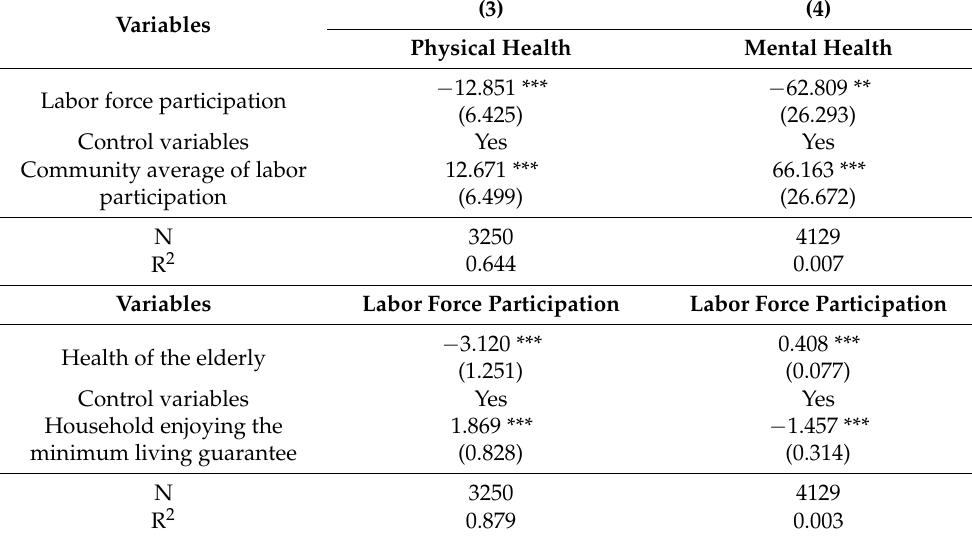
Table 4. Simultaneous equation regression